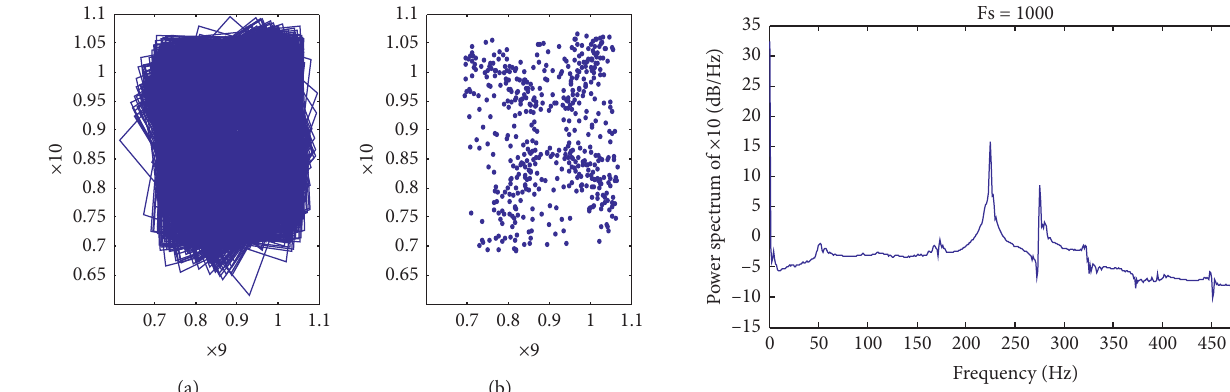
Figure 45: Power spectrum of x ω �